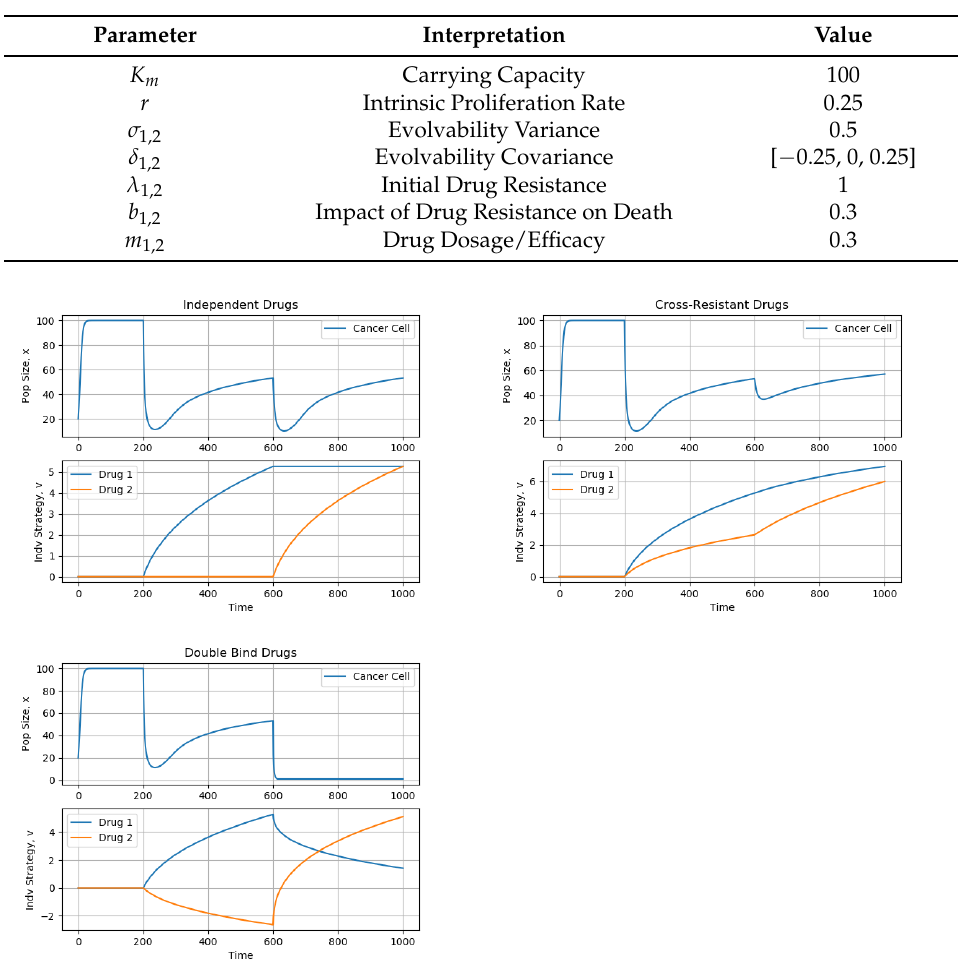
Table 3. Parameter values used in combination therapy simulations.